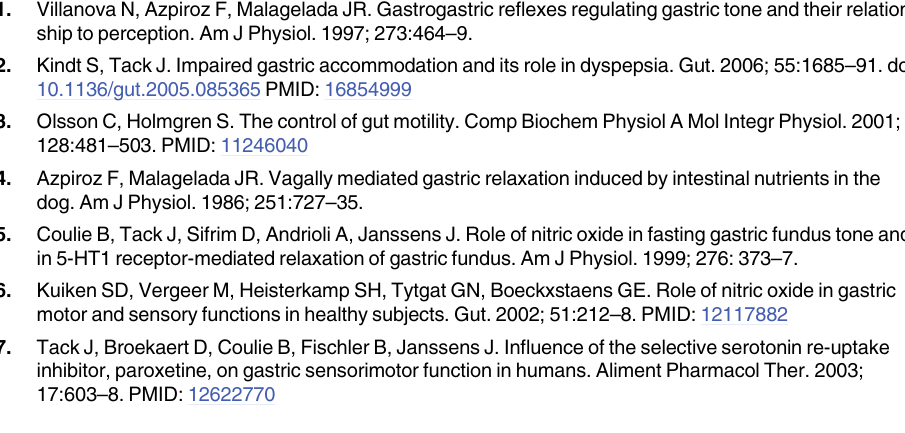
S1 Fig. The Western blot analysis of c-Kit in different aged rat group. The original data of c-Kit protein analysis in different aged rat groups; 6-wk-old rat group ( n = 10), 31-wk-old rat group ( n = 10), 74-wk-old rat group ( n = 8) and 2-yr-old rat group ( n = 12). (TIF) S2 Fig. The Western blot analysis of nNOS in different aged rat group. The original data of nNOS protein analysis in different aged rat groups; 6-wk-old rat group ( n = 10), 31-wk-old rat group ( n = 10), 74-wk-old rat group ( n = 8) and 2-yr-old rat group ( n = 12).